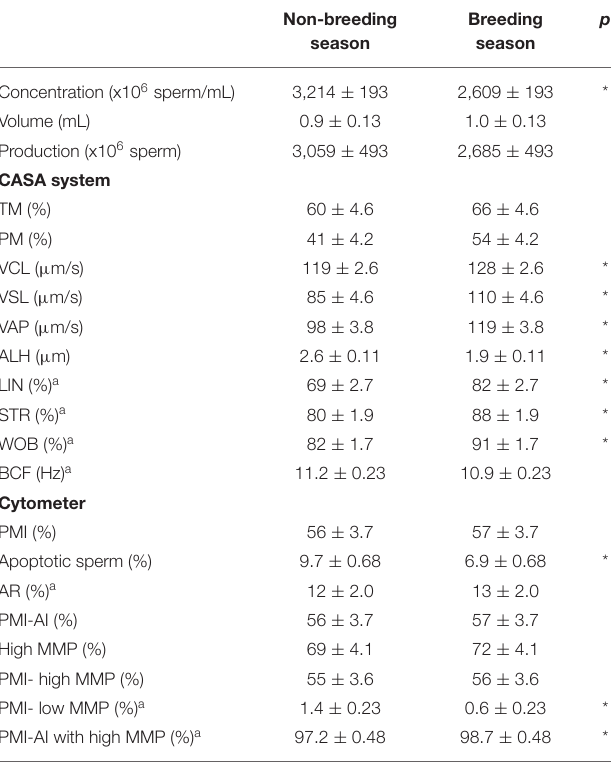
TABLE 1 | Quality of the fresh goat buck ejaculates collected during the non-breeding and breeding